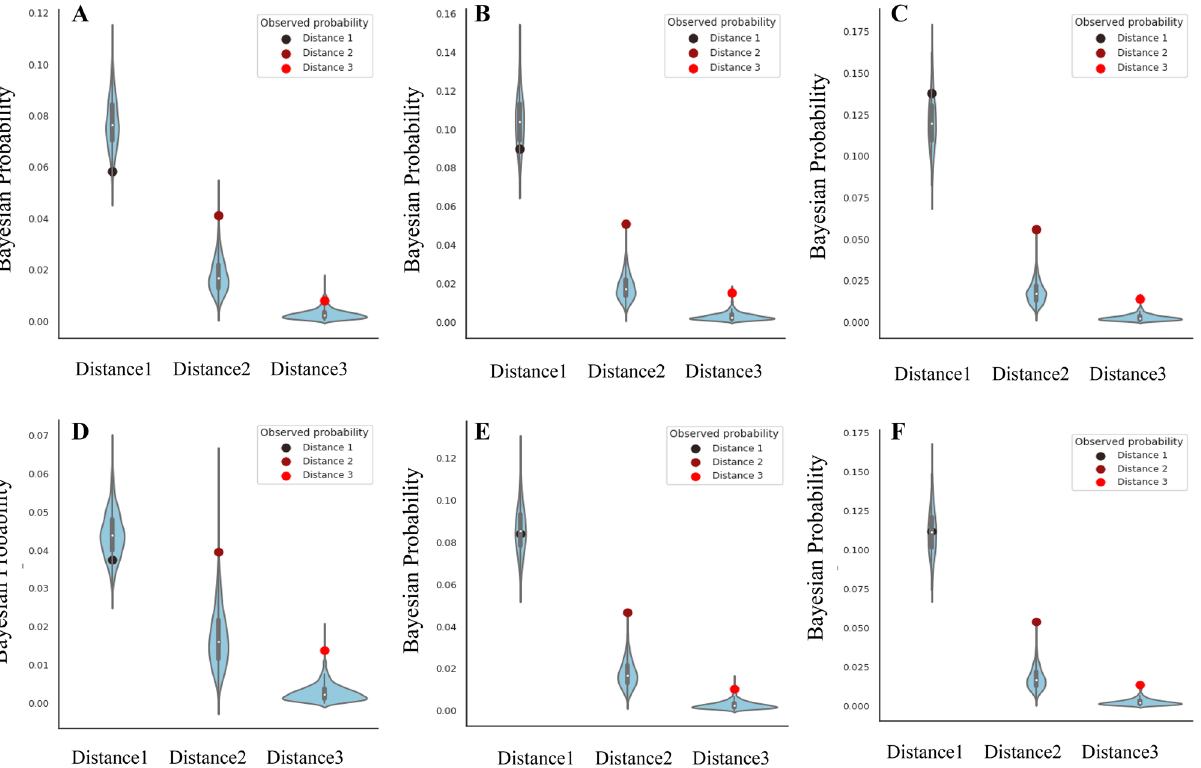
Figure 6. Differences in social contagion of gambling abstinence among comment categories. ( A ) Rejective comment networks, ( B ) Acceptive comment networks, ( C ). Neutral comment networks, ( D ). Sustain comment networks, ( E ). Change comment networks, ( F ). General comment networks. The red dots are the observed probabilities, and the blue shapes are kernel density estimations of the underlying distribution of simulation results. The simulation results of A , B , C , D , E and F were obtained from 1000